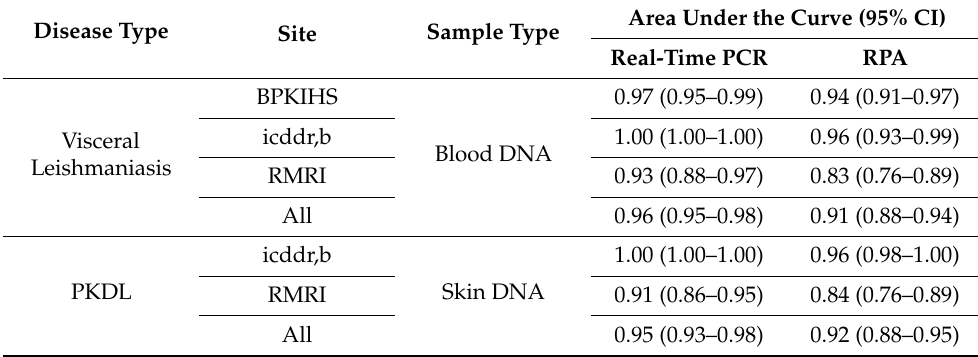
Table 5. Determination of the area under the curve (AUC) for each of the methods in diagnosis of both VL and PKDL with blood and skin specimens,